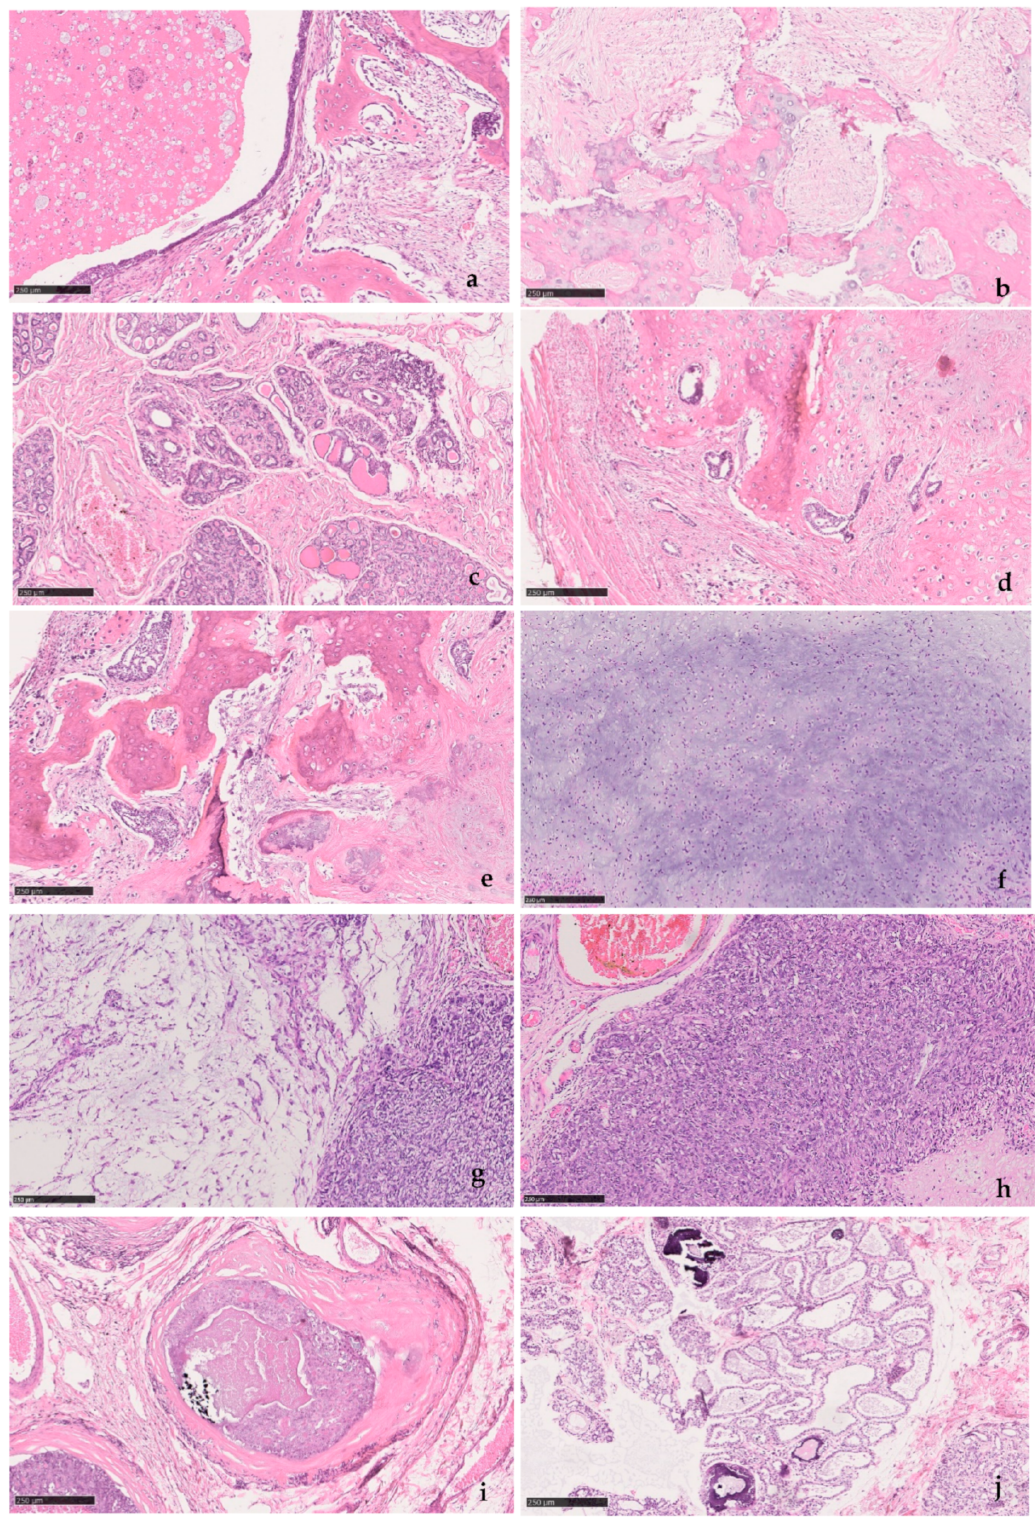
Figure 1. Histopathology findings (H&E): ( a ) #1 Mixed benign tumor; ( b ) #2-1 Mixed benign tumor; ( c ) #2-2 Glandular tissue; ( d , e ) #3 Mixed malignant tumor, with epithelial and mesenchymal cell proliferation and foci of bone and chondroid metaplasia; ( f ) #4 Carcinosarcoma (mesenchymal); ( g ) #4 Carcinosarcoma (myoepithelial and epithelial); ( h ) #4 Carcinosarcoma (epithelial); ( i ) #5 Comedocarcinoma; ( j ) #6 Glandular tissue with mineralization foci within acinar